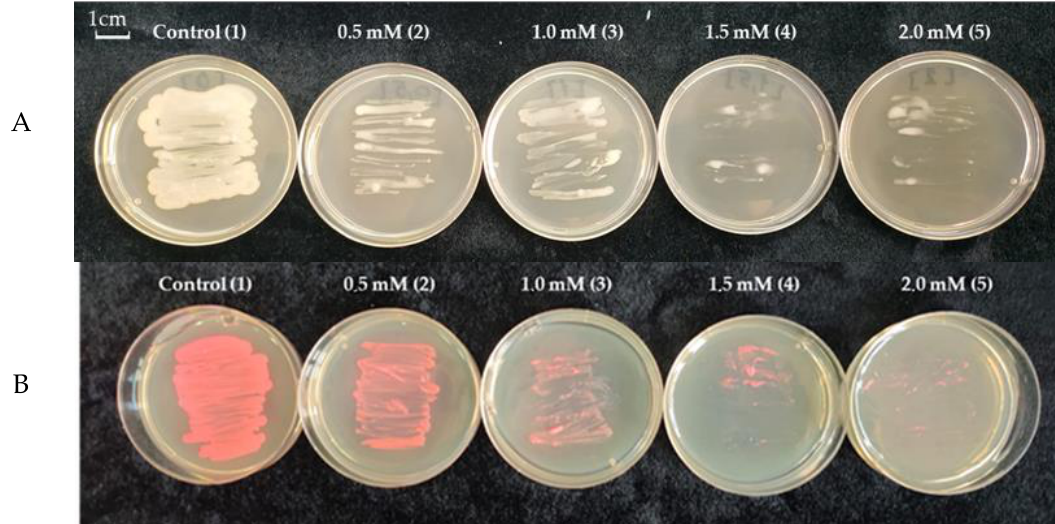
Figure 2. A - The growth of the strain Pseudomonas sp. OBA 2.4.1 (1) on LB medium, (2) with the addition of 0.5 mM Cd, (3) with the addition of 1 mM Cd, (4) with the addition of 1.5 mM Cd, (5) with the addition of 2 mM Cd; B - the growth of the strain Pseudomonas sp. OBA 2.4.1 transformed with plasmid pJNTurboRFP (which gives a pink color to the bacteria) (1) on LB medium, (2) with addition of 0.5 mM Cd, (3) with addition of 1 mM Cd, (4) with addition of 1.5 mM Cd, (5) with the addition of 2 mM Cd. The bar in the photograph indicates 1 cm.